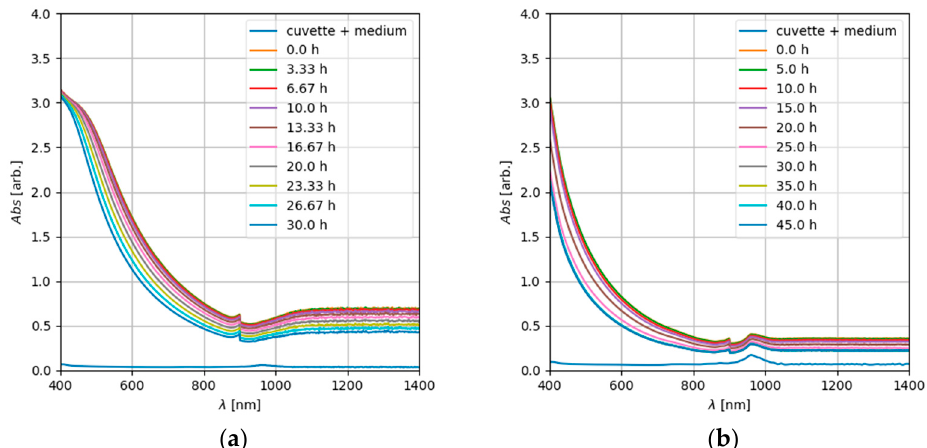
Figure 9. Time series of UV-Vis spectra of ZnO nanoparticles (NM 110) dispersed in cell culture medium (treatment; see Section 2.2) at a concentration of c = 2.56 mg/mL ( a ) and 0.256 mg/mL ( b ); the lowermost spectrum represents the medium without particles.